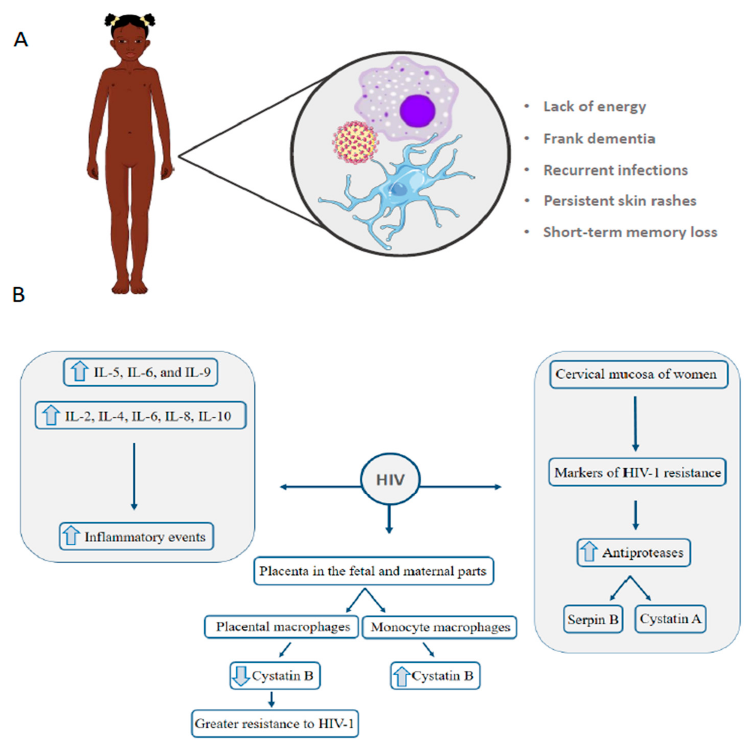
Figure 3. Main symptoms in children who contracted HIV through vertical transmission. Macrophages and microglia are reservoirs for viral multiplication and their immune functions are impaired ( A